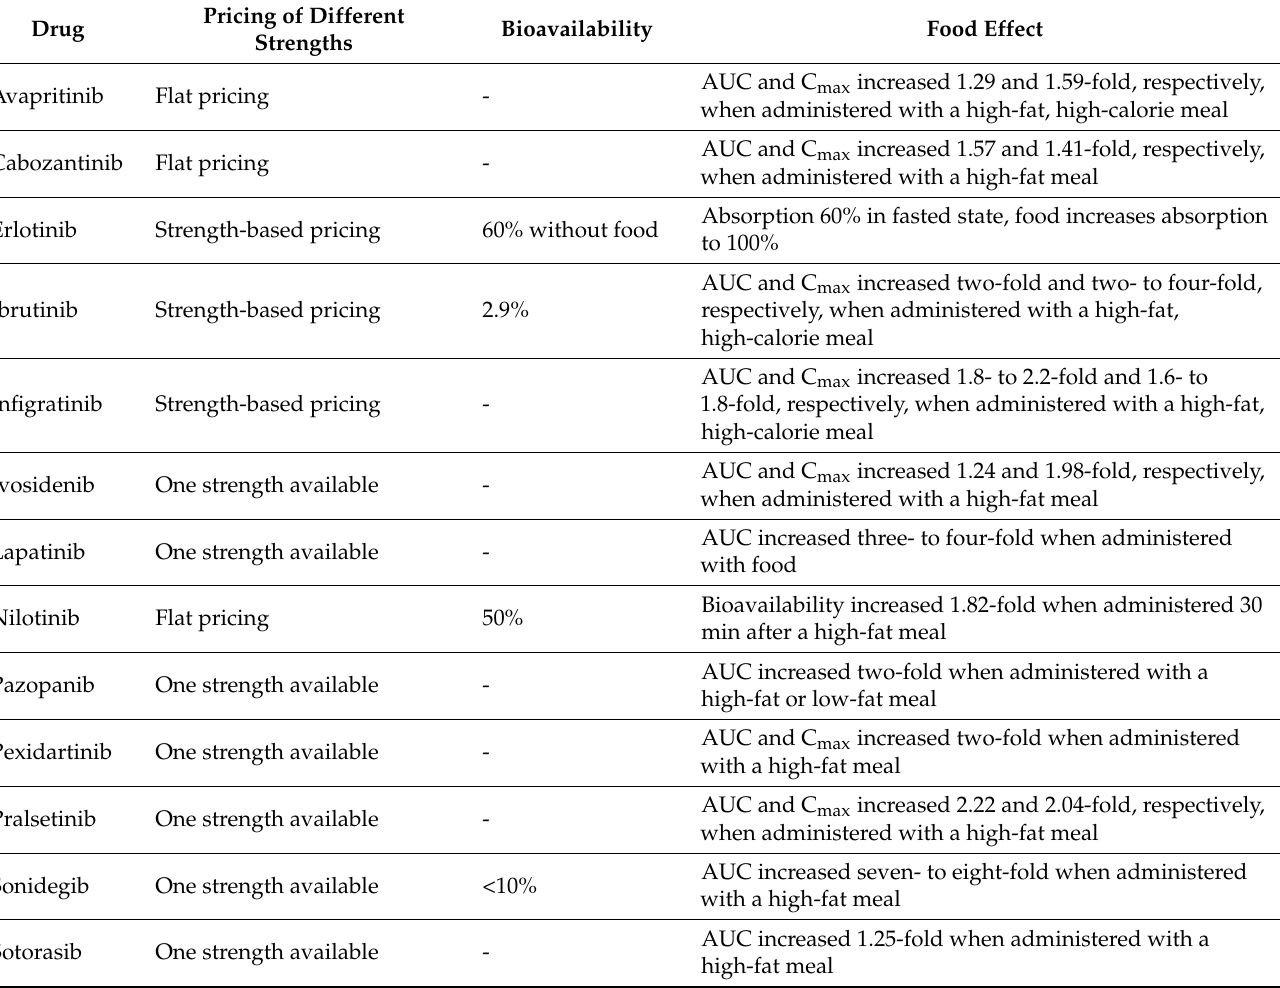
Table 4. Final selection of potential food boosting candidates ( n = 13). Relevant drug characteristics were retrieved from the Summary of Product Characteristics (SmPC), European Public Assessment Reports (EPAR) and UpToDate